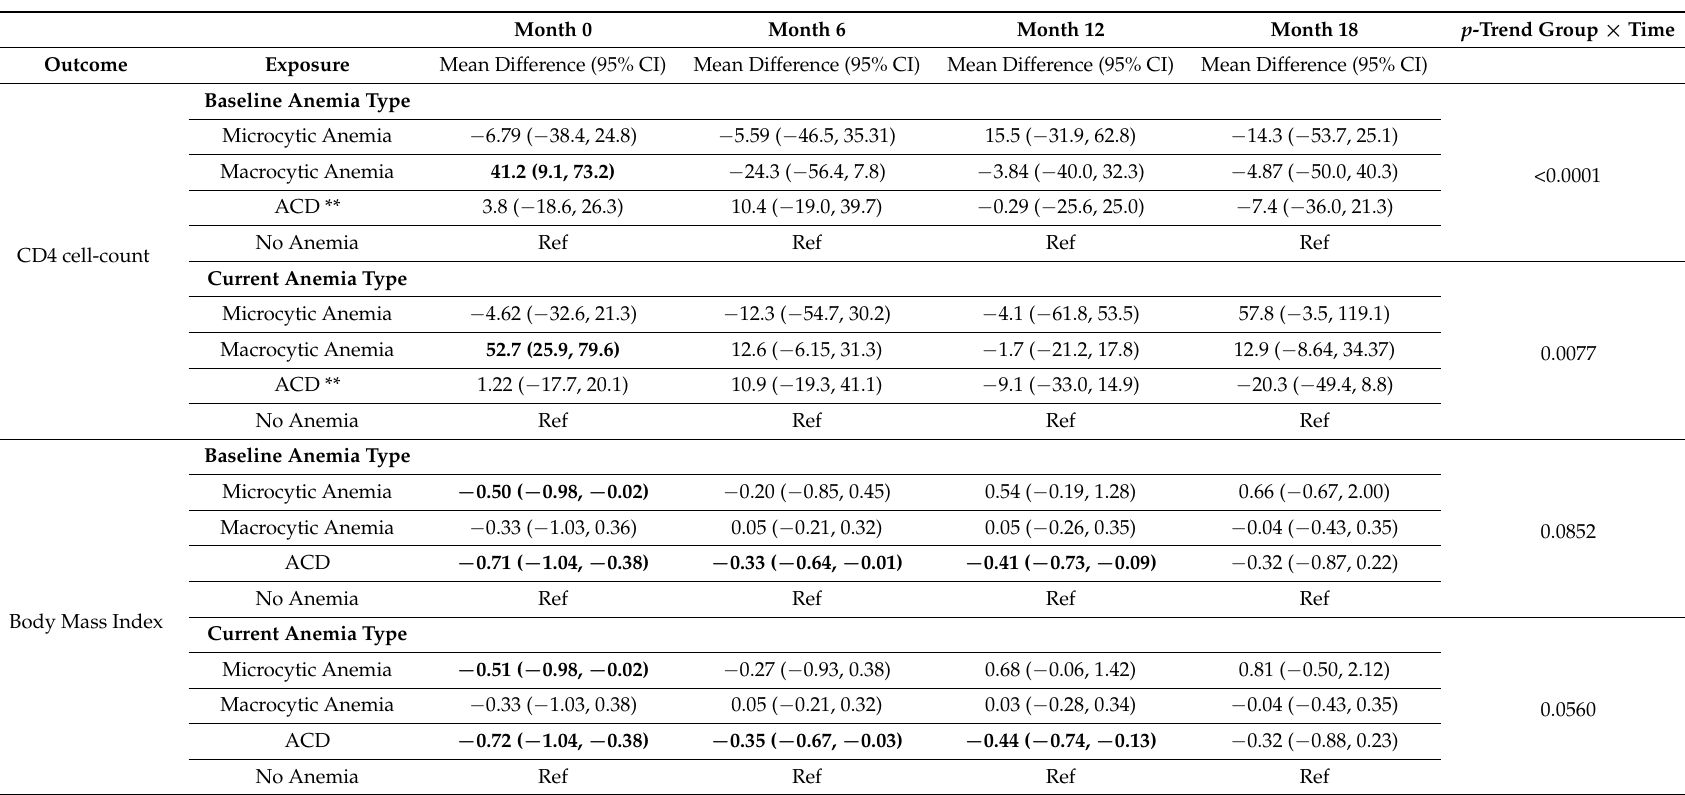
Table 4. The baseline and Current Anemia type in relation to the change in absolute CD4 cell count, Body mass index, quality of life and frailty score Over 18 months